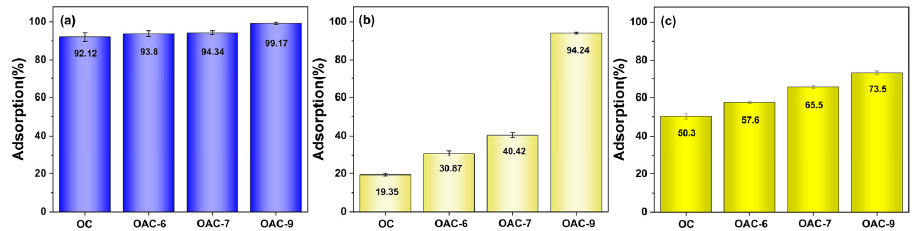
Figure 6. Adsorption equilibrium of the adsorbents for 10 mg L − 1 of ( a ) MB, ( b ) NaFL, and ( c ) TC for a period of 2 h.